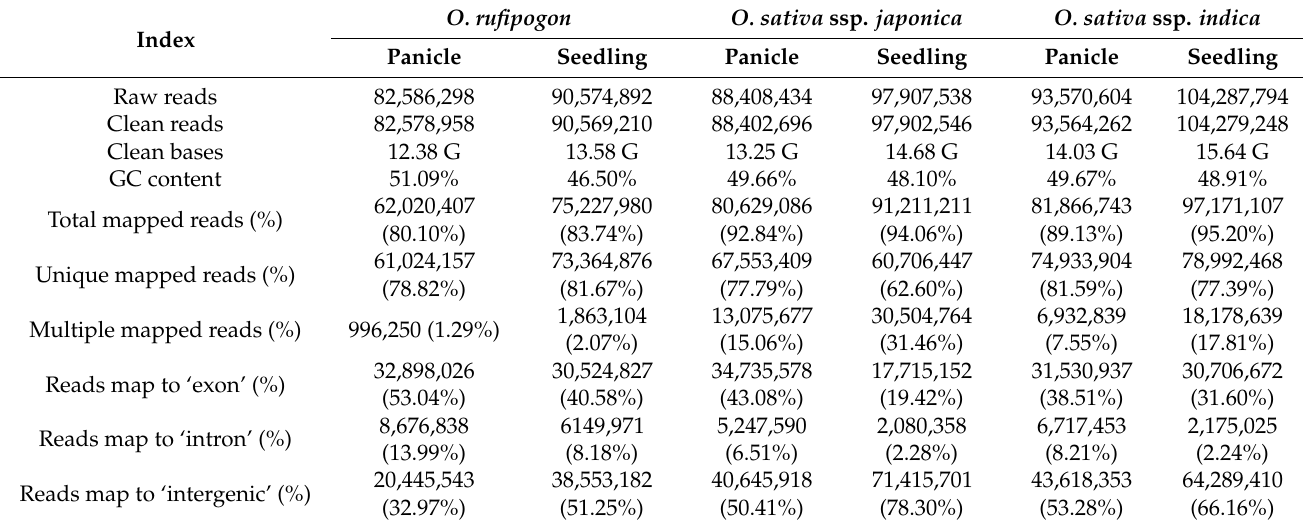
Table 1. A summary of data from lncRNA